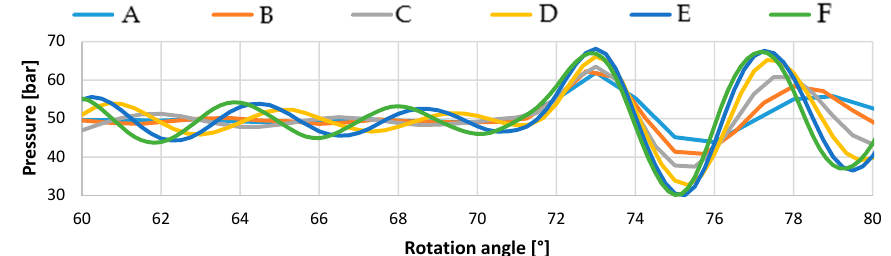
Figure 13. Influence of the time step size on the displacement chamber pressure ripple while the chamber is connected to the delivery port.